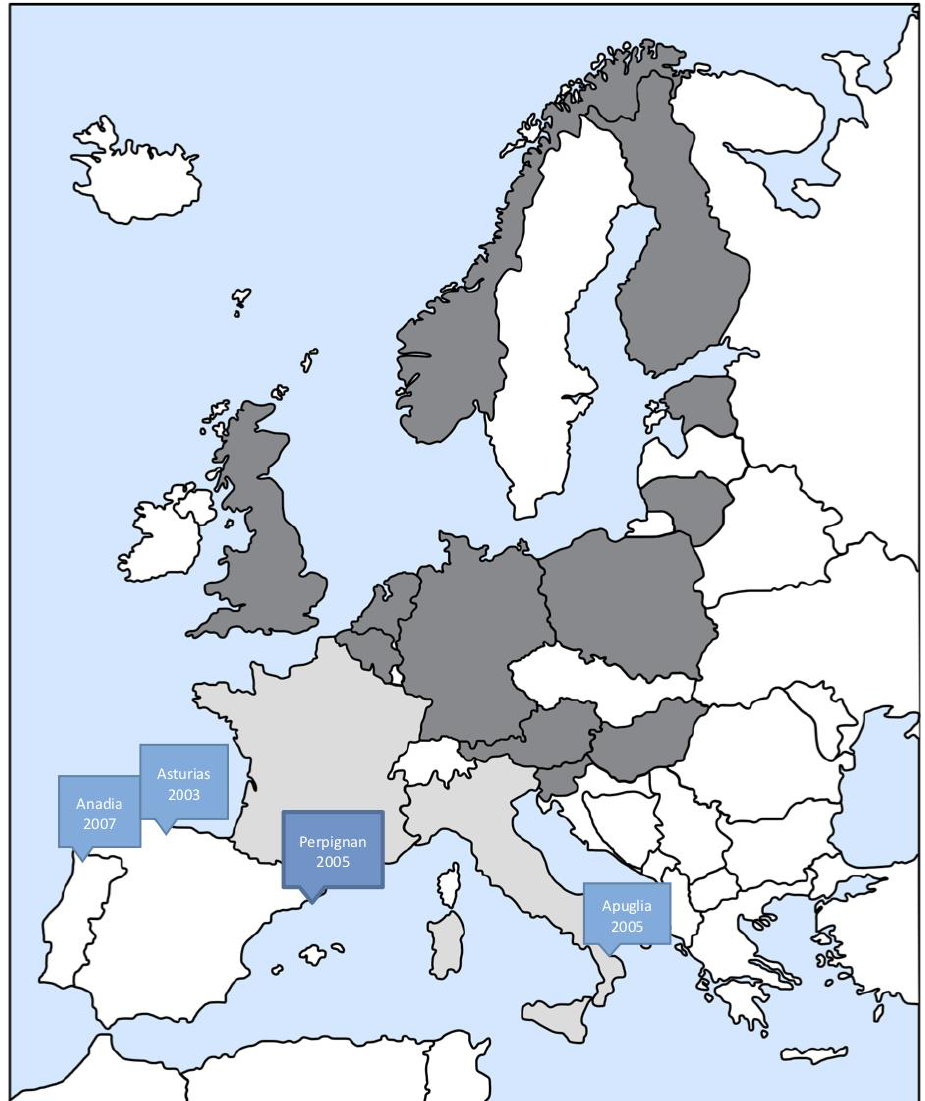
Figure 4. Year and location of first reports of Fusarium circinatum in countries within the European Union according to EPPO [70]. White = no information available, Light grey = pest absent, eradicated; grey = pest absent, confirmed by survey, black = pest present .